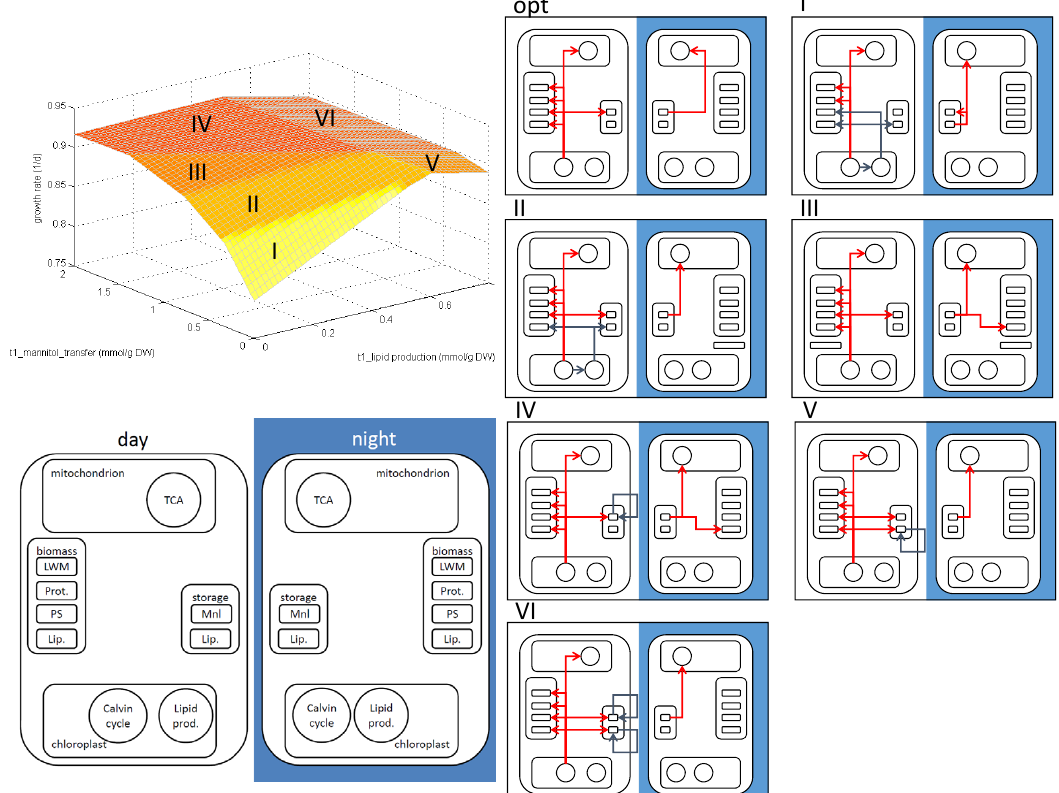
Figure 5. Top left: phenotypic phase plane plot of the stoichiometric model for mannitol transfer from day to night metabolism and lipid production; bottom left: schematic of metabolic pathways and metabolites to categorize the carbon flux distribution in different metabolic modes; right: carbon distribution in the region marked in the phenotypic phase plane (PhPP). Different arrow colors are used for visual distinction